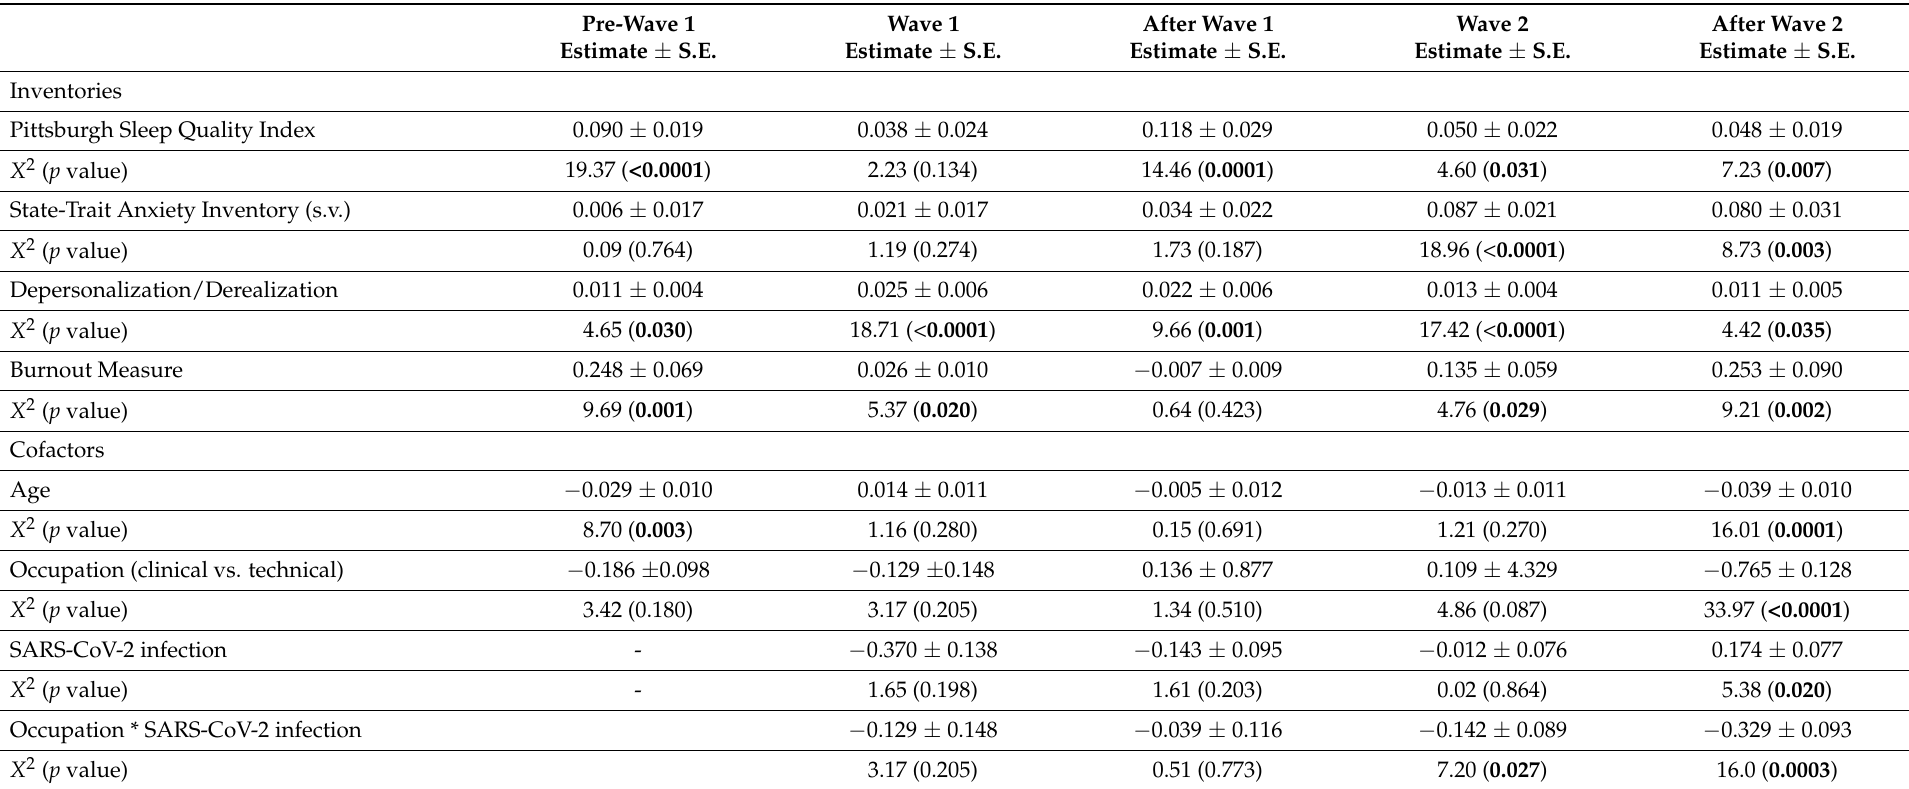
Table 4. Results of the multivariable analysis on the score of the Stanford Acute Stress Questionnaire at each time point of evaluation, including the follow-up inventories, age, occupation, and cumulative SARS-CoV-2 infection. Statistical significance is highlighted in